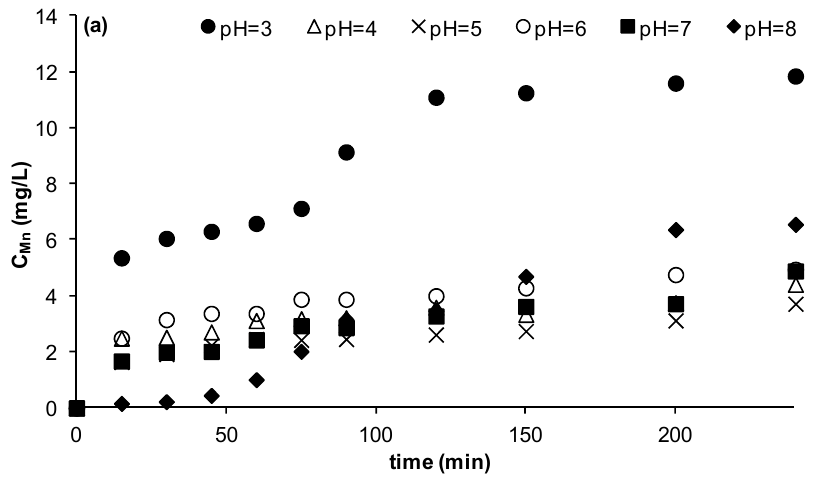
= 0.0709 mg Mn/g Mn